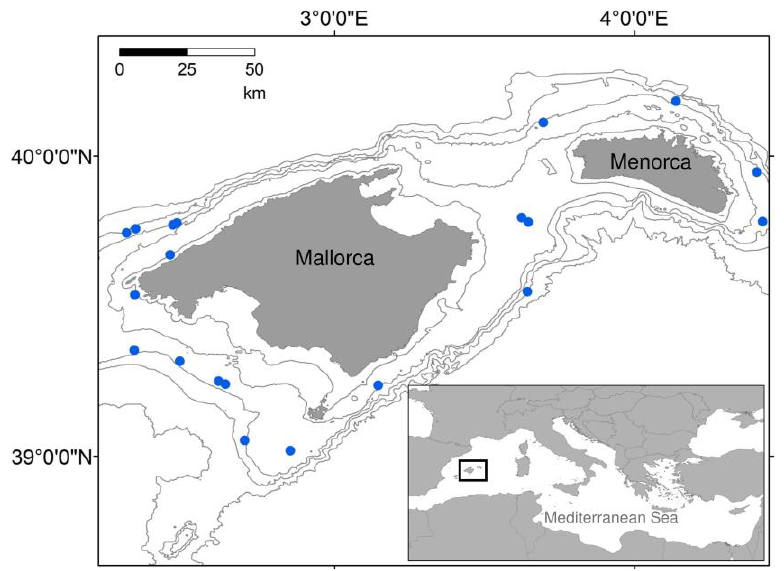
Figure 1. Location of the Raja clavata samples that were genetically analysed. Isobaths: 50, 100, 200, 400 and 800 m.